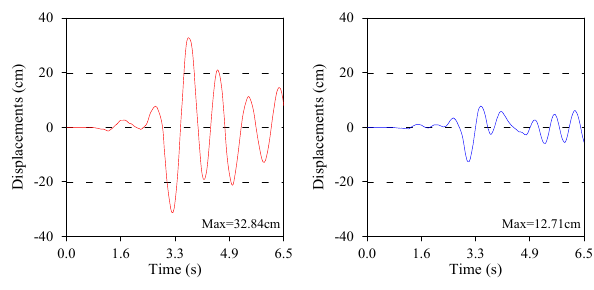
0.0 0.0 Figure 9 Time histories of maximum displacements at the top of minaret for both analyses Figure 10 points out the contours of maximum horizontal displacement corresponding to both analyses. These displacement contours represent the distribution of the peak values reached by the maximum displacement at each point within the section.